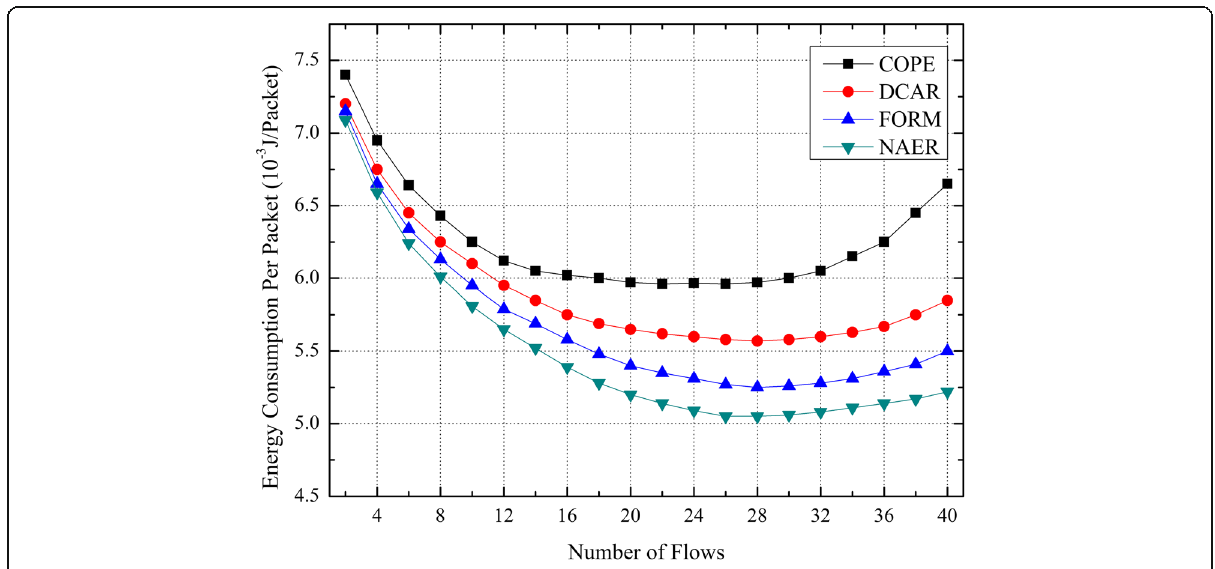
Fig. 21 Energy consumption per packet under different number of flows in grid network. Figure 21 shows the energy consumption per packet comparison of COPE, DCAR, FORM, and NAER under different number of flows in grid